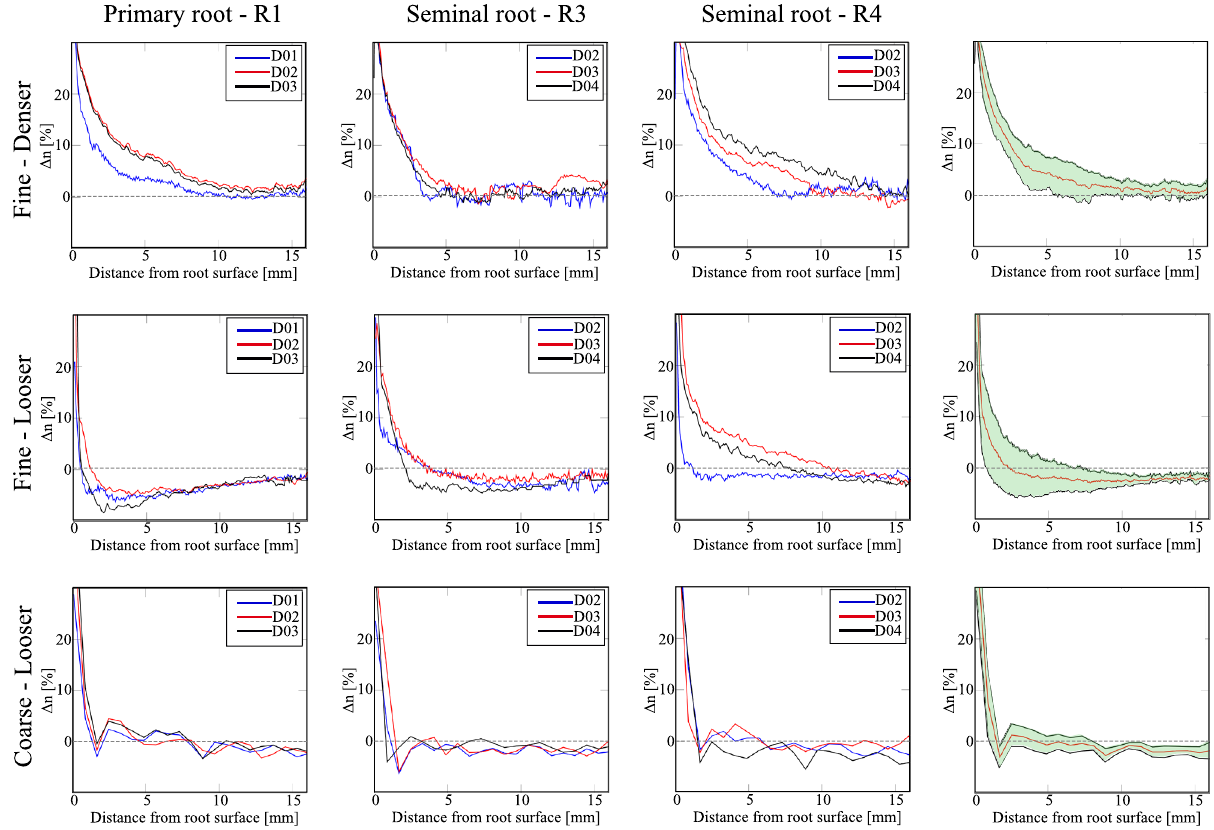
Figure 6. Variation of soil porosity (cid:31) n with the distance from the root surface. Compilation of the results for three different root tips in the three different soil configurations. The last column shows the mean porosity along with the standard deviation (as a shaded